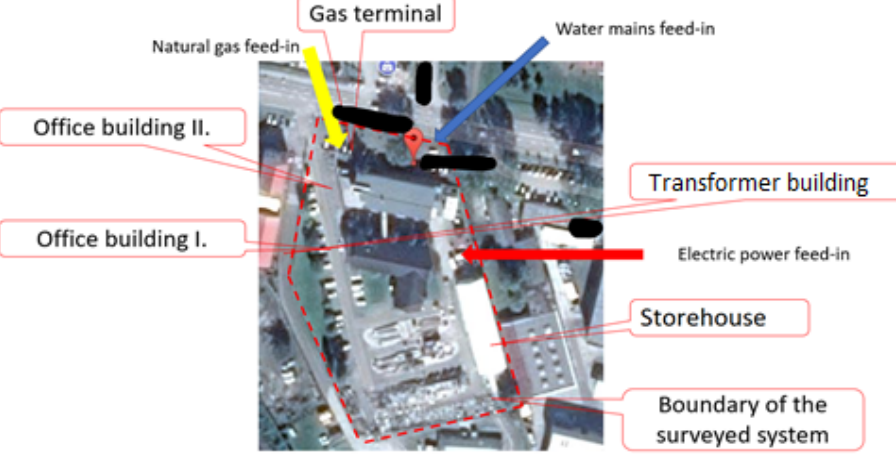
Figure 1. The pilot site and the boundary of the surveyed system.